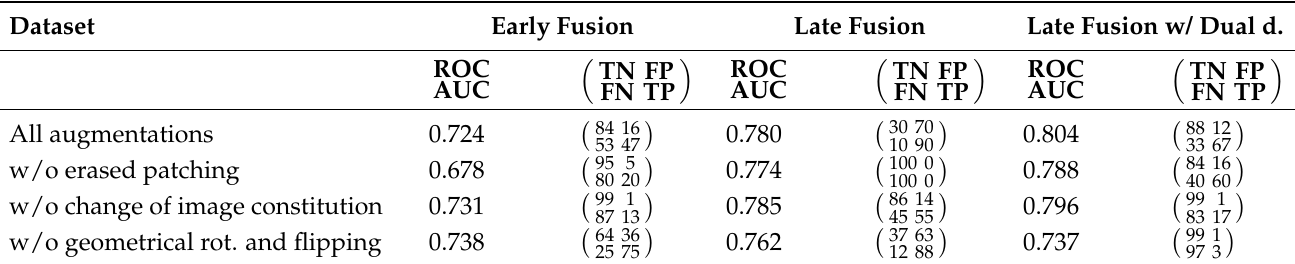
Table 7. ROC AUC scores for different augmentation techniques. A denoising autoencoder is employed in the pre-training stage of Deep SVDD [6] for each of the fusion techniques. The results portray the performance on multi-perspective dices test dataset with augmentation. The confusion matrices are given in %.